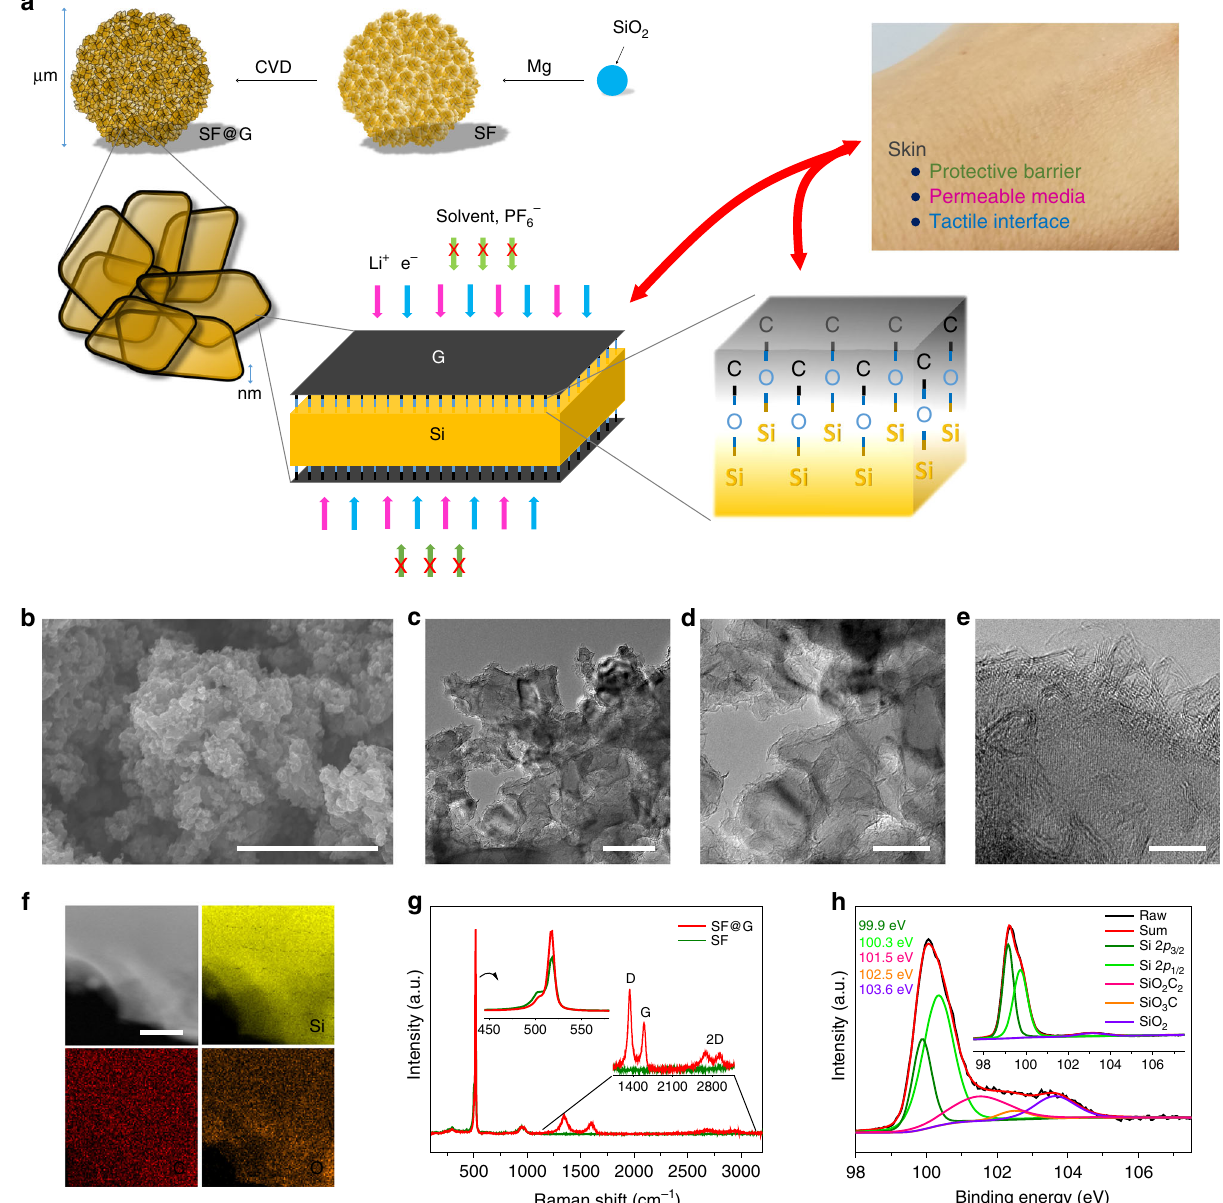
Fig. 2 Fabrication and characterization of SF@G. a Schematic of the fabrication process for SF@G. The synthesized SF@G features a two-dimensional covalently bound component interface, enabling stable and fast electron (e − ) and lithium-ion (Li + ) transport, while fundamentally blocking undesirable substances such as the electrolyte solvents (EC, DEC) and anions (PF 6 − ), mimicking the skin functions typically as a protective barrier, a permeable media, and a tactile interface. b SEM image of SF@G. c – e TEM images of SF@G. f Scanning transmission electron microscopy (STEM) and elemental mapping images of SF@G. g Raman spectra of SF@G and SF with magni fi ed regions in the insets. h Si 2 p XPS spectrum of SF@G along with that of SF in the inset, indicating the covalent binding at the Si/C component interface of SF@G. Scale bars, 2 µ m ( b ), 100 nm ( c ), 50 nm ( d ), 10 nm ( e ), and 100 nm ( f